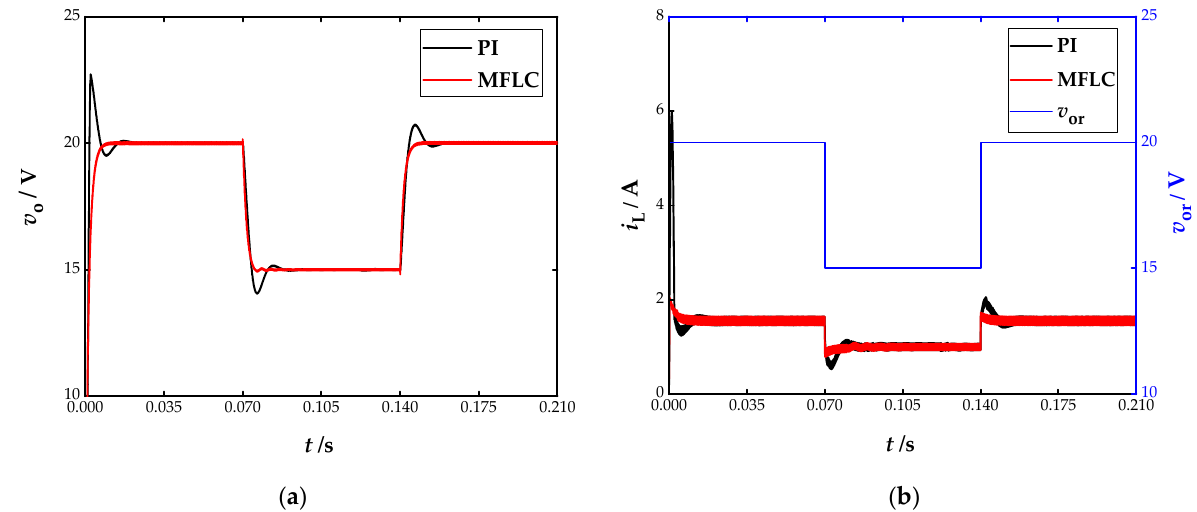
Figure 7. The response of the buck-boost converter when the reference voltage v or changes suddenly at 0.07 and 0.14 s, respectively. ( a ) Response curve of the output voltage v o ; ( b ) Response curve of the input current i L